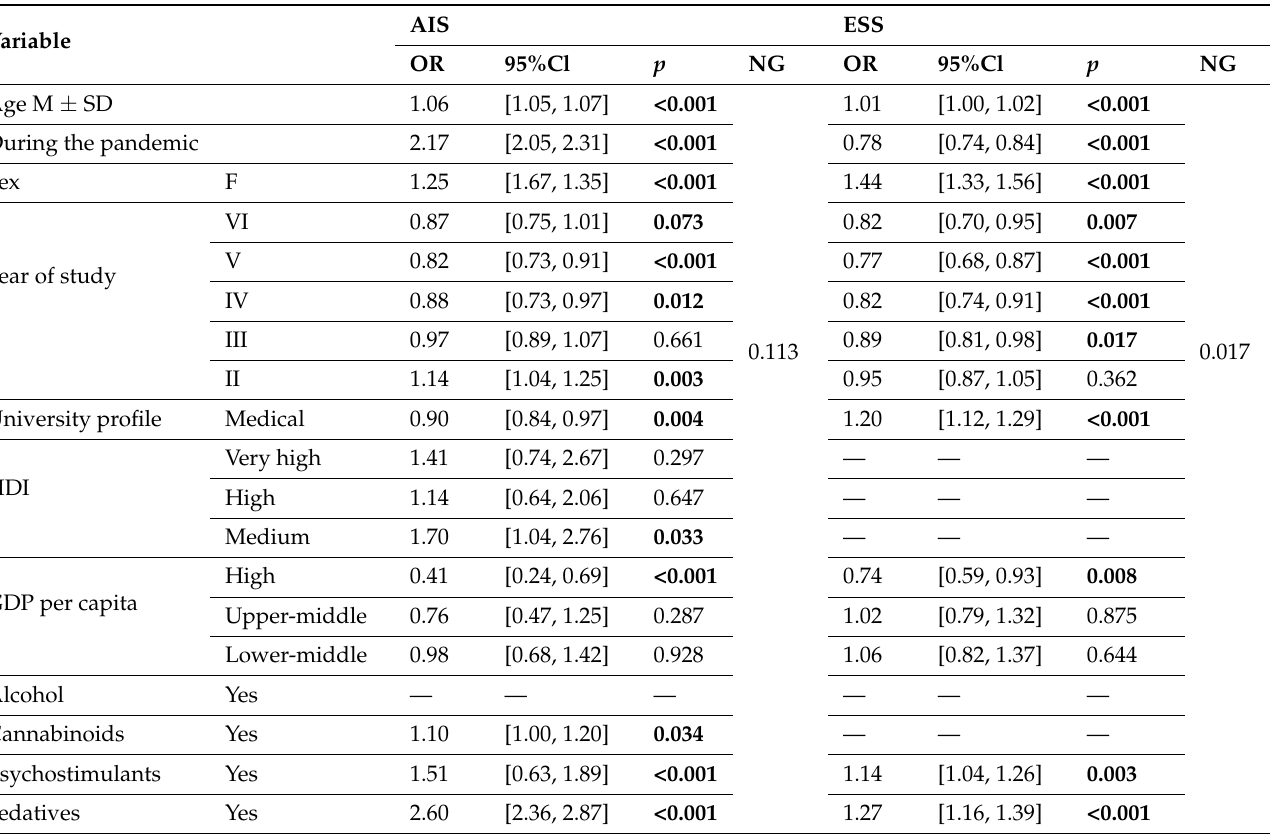
Table 2. The backward stepwise logistic regression model assessment of the effects of sociodemo- graphic variables, university profile, pandemic, place of residence, and psychoactive substance use on insomnia and daytime sleepiness.